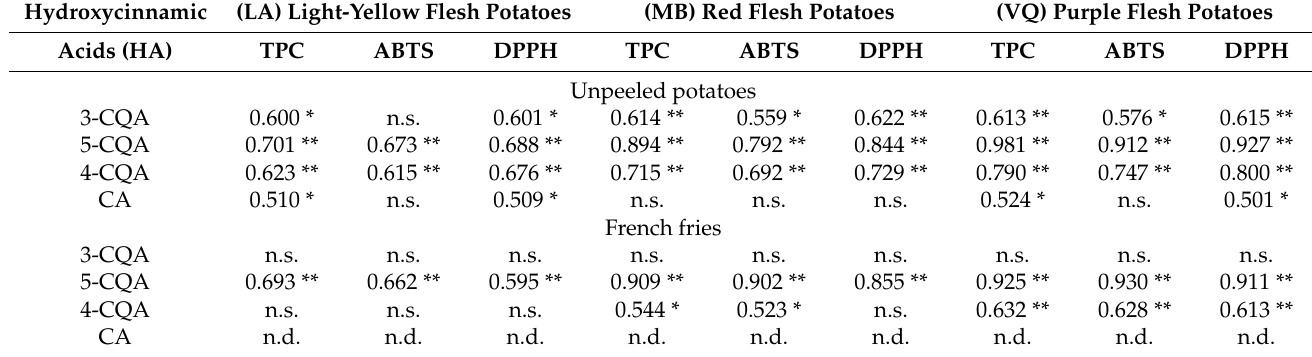
Table 4. Correlation coefficients (r) for hydroxycinnamic acids, total phenolic content (TPC) and antioxidant activity (ABTS and DPPH) in potatoes with different coloured flesh and samples obtained during the processing of French